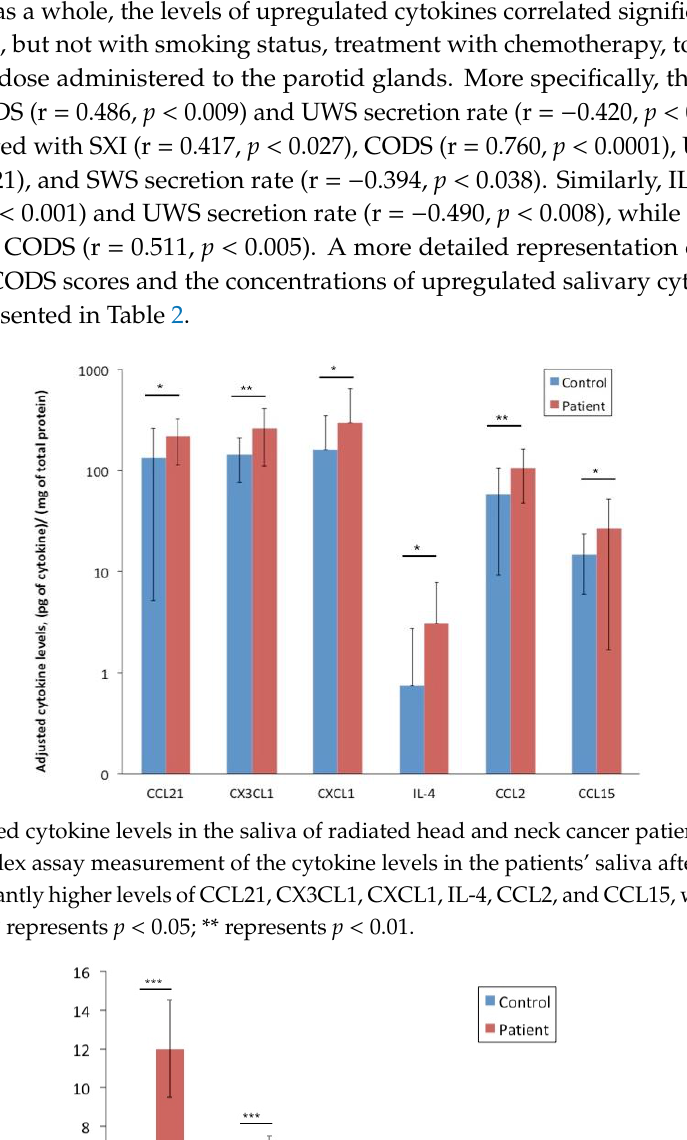
unstimulated whole saliva secretion rate (ml/min); SWS: stimulated whole saliva secretion rate